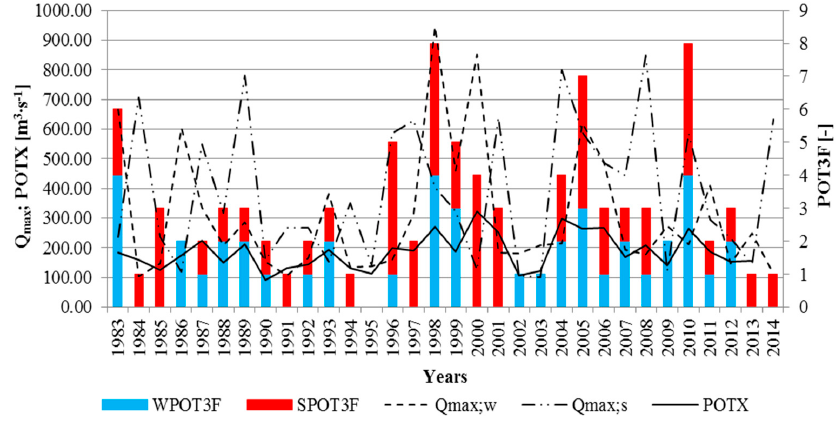
Figure 6. Q max;w , Q max;s , POTX, WPOT3F, SPOT3F and POT3F metrics for the catchment of the San at Przemy ś l cross ‐ section.